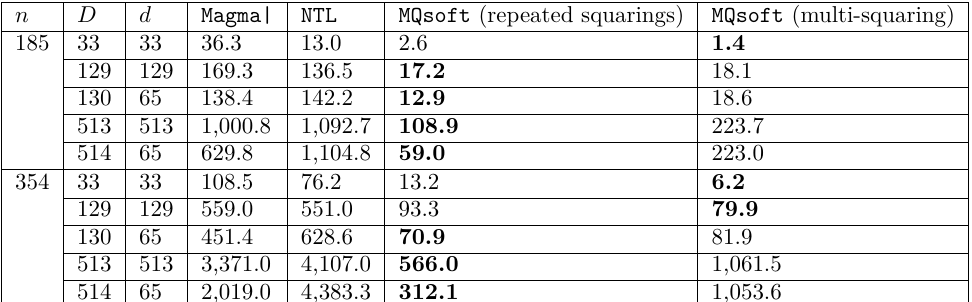
Table 12: Number of mega cycles to compute the Frobenius map of a HFE polynomial. We use a Skylake processor